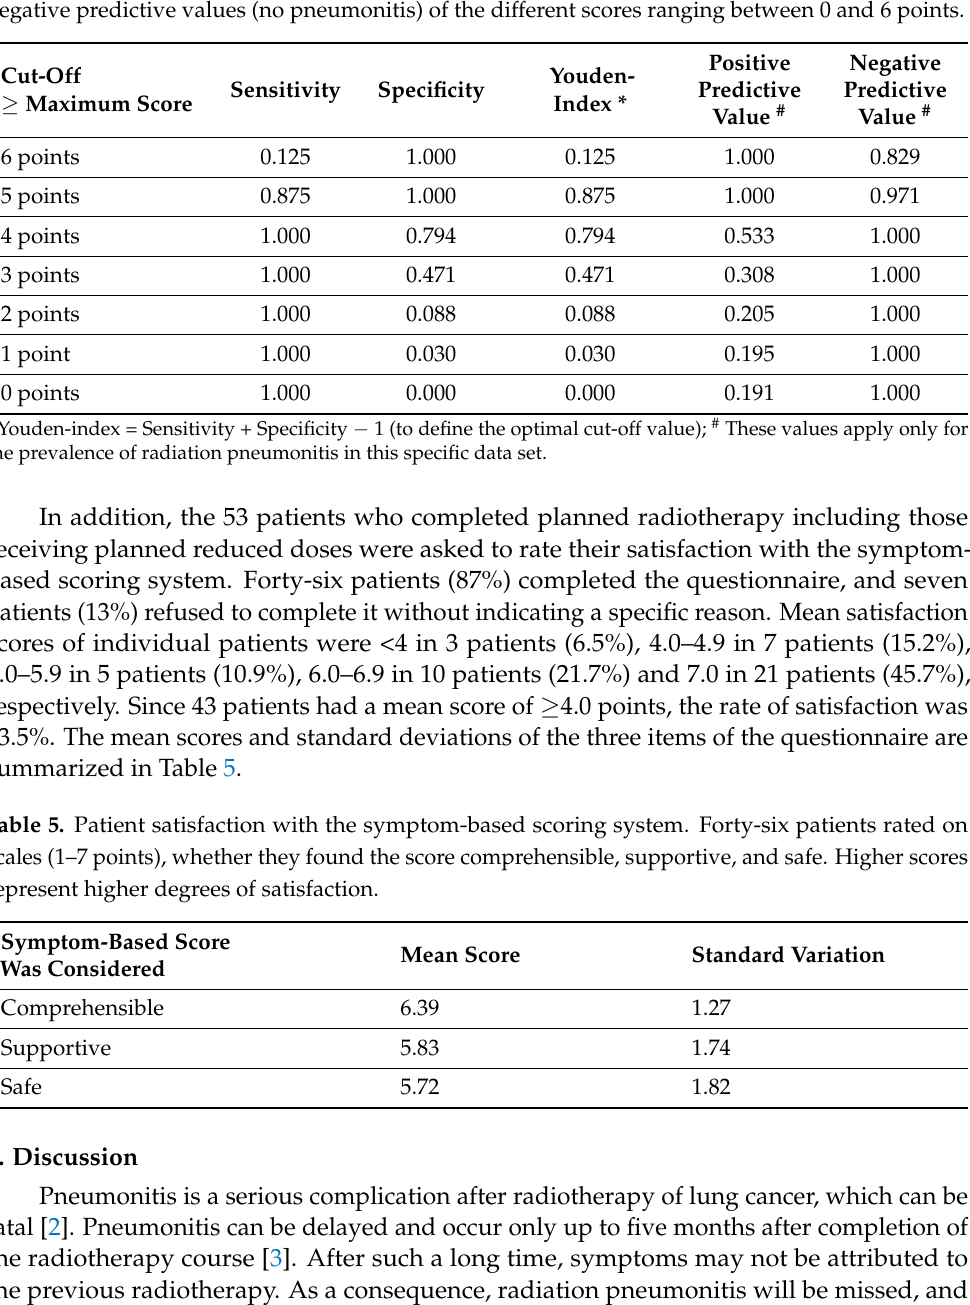
Negative Positive Youden- Predictive Predictive Index * Value #